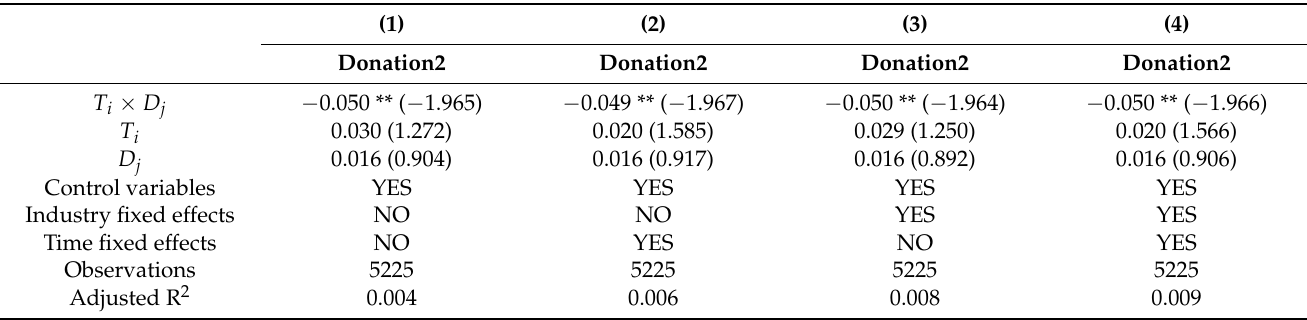
Table 6. Robustness tests for alternative the dependent